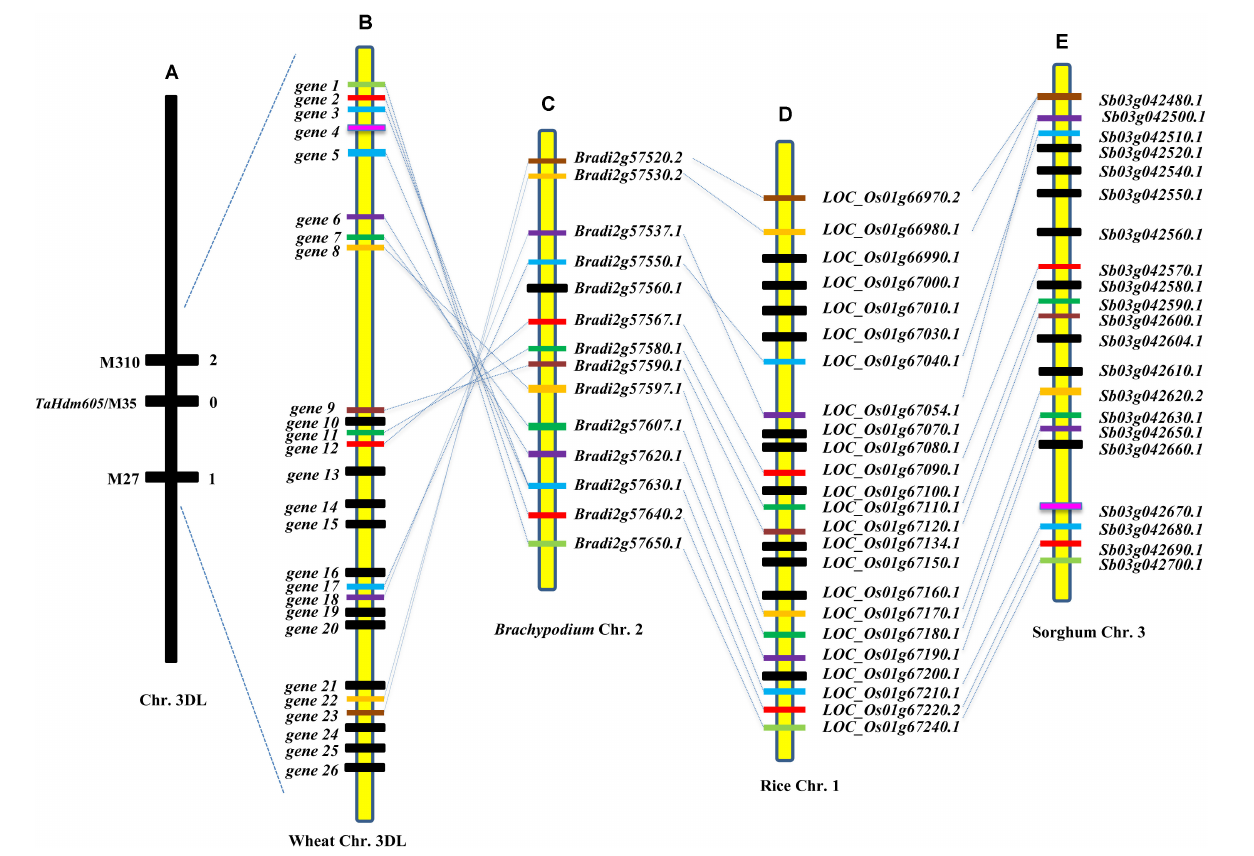
FIGURE 3 | Fine mapping of TaHdm605 and comparative genomics analysis of the surrounding region in wheat, Brachypodium , rice, and sorghum. (A) Genetic linkage map of the heading date gene TaHdm605 on wheat chromosome arm 3DL. Horizontal lines indicate mapping marker locations, and the number of recombinants is shown on the right. (B) Physical map of the TaHdm605 locus based on Chinese Spring 3DL sequences. The horizontal lines represent the predicted wheat genes. (C) Orthologous genomic region of TaHdm605 on Brachypodium chromosome 2. (D) Orthologous genomic region of TaHdm605 on rice chromosome 1. (E) Orthologous genomic region of TaHdm605 on sorghum chromosome 3. For (B–E) orthologs are indicated by diagonal